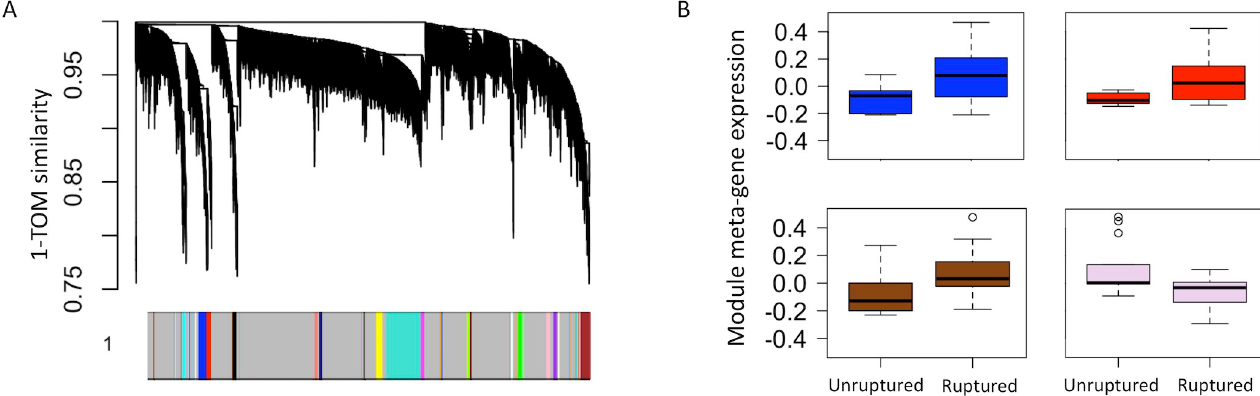
Fig 1. Module-based analysis reveals differences between immune processes in ruptured vs unruptured aneurysms. A: Dendrogram demonstrating the taxonomic relationship between genes with the y-axis representing gene dissimilarity based on the TOM metric. Colour bar representing genes grouped into modules. Grey interspacing represents unclassified genes. B: Boxplots of module meta-gene expression for significant modules which annotate to immune function. Both the blue and red modules (320 and 164 genes, respectively) annotate to inflammation/innate immunity. Similarly, the brown module (29 genes) annotates mostly strongly to Il-1 and TNF, while the lavender module (4 genes) enriches in B cells and phagocytosis predominantly. The horizontal lines represent median value, with the box representing interquartile range (first and third quartile represented by the bottom and top of the box, respectively). Whiskers represent the data range, with a maximum extension of 1.5 times the interquartile range. Values falling outside this range are considered outliers and represented by small circles.